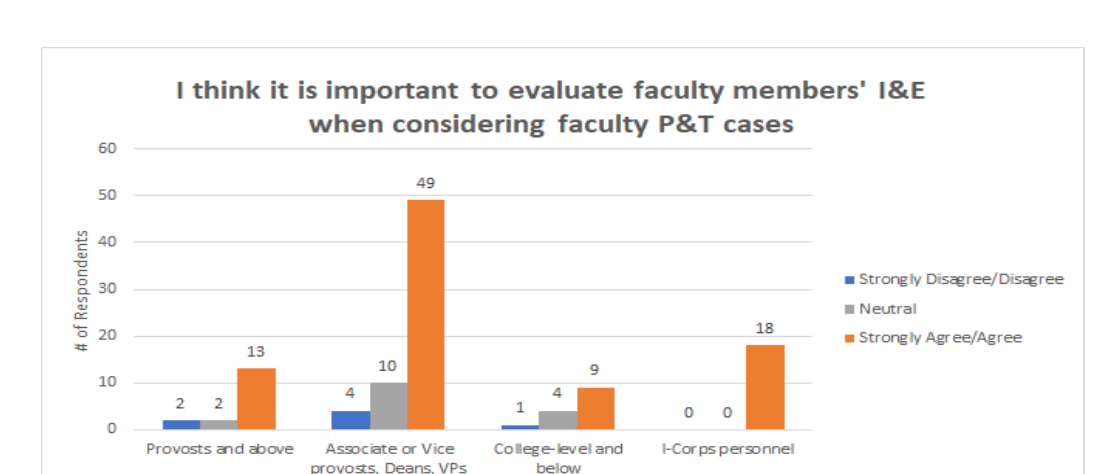
Figure 2. Comparison of IHE personnel’s perceptions of the importance of evaluating faculty members’ I&E when considering faculty P&T cases at their institutions.